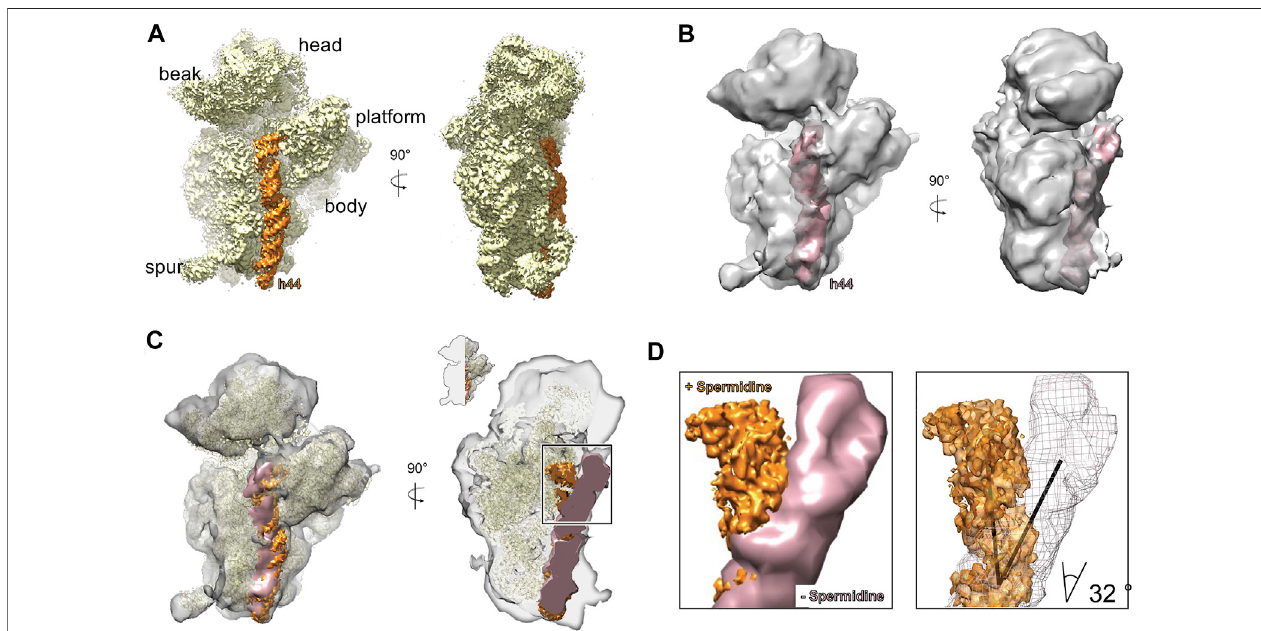
FIGURE 2 | Addition of spermidine stabilizes helix 44 of the 30 S. A. An overview of the structure of 30 S subunit prepared with addition of 2.5 mM spermidine (A) and without spermidine (B) . The h44 is highlighted in orange and pink respectively. (C) An overlay of the structures showing that without spermidine, h44 is destabilized andbentawayfromthehead.FortheA-siteview(right)structureswereclippedasindicatedintheinset. (D) Aclose-upviewonh44conformationin30Swithadditionof spermidine (orange) and without it (pink/mesh). The calculated angle of the tilt is 32 ° .